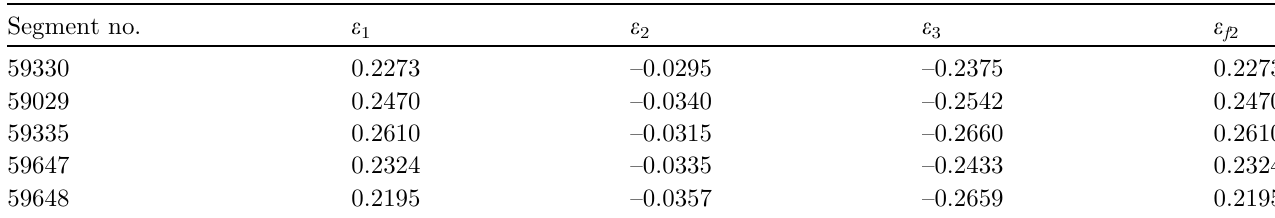
Table 4. Effective strain of the dangerous cross-section segments on the seal ring in the inner cavity of the tip. Segment no.